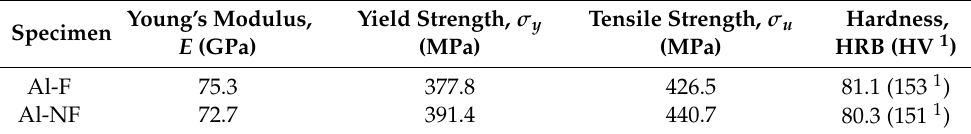
Table 2. The mechanical properties of the Al-F and Al-NF aluminum alloys.